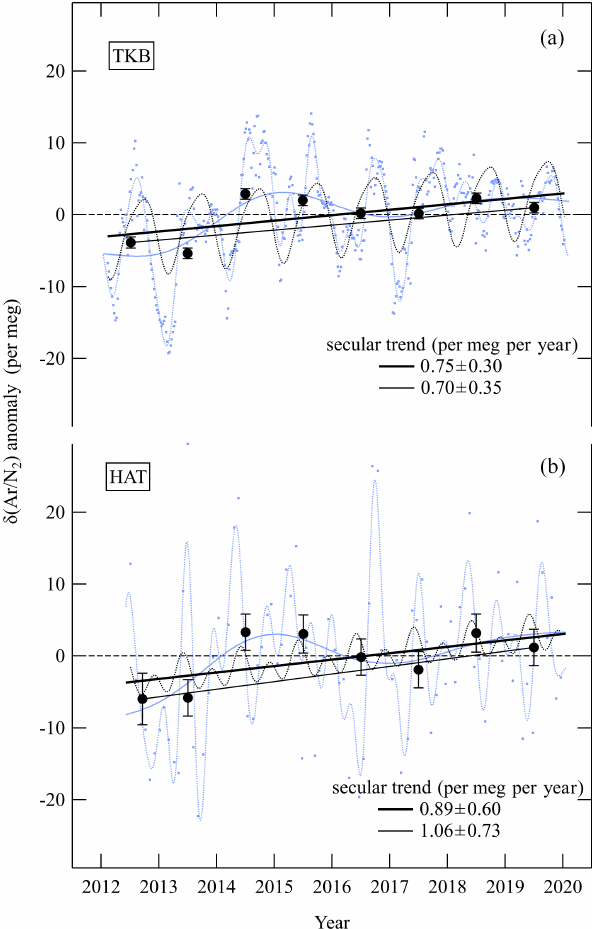
Figure 5. Same observed values (blue dots), best-fit curves to the data (blue dotted lines) and interannual variations (blue solid lines) of δ (Ar / N 2 ) at TKB (a) and HAT (b) as in Fig. 2. Data are ex- pressed as anomalies from the average value for the observation period. Other best-fit curves consisting of the fundamental, its first harmonics and a linear secular trend to the observed data are also shown (black dotted lines). The components of the linear secular trend of the best-fit curve are shown by thick black solid lines. In order to address the uncertainty of the secular trend, uncertainties around the regression and the long-term stability of the standard air ( ± 1 . 6 per meg, blue circles in Fig. 1b) have been taken into account. Annual average values of δ (Ar / N 2 ) at TKB and HAT (filled black circles) and the secular trend at each station calculated as the dif- ference between the 2012 and 2019 annual average values are also plotted (thin black solid lines). Error bars for the annual average values at TKB and HAT are evaluated considering the uncertainty of each analysis value of the standard air (black dots in Fig. 1b) and the uncertainty associated with repeated analyses of the same air